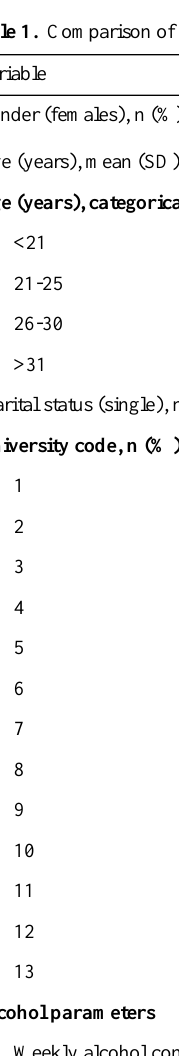
Table 1. Comparison of groups at baseline.